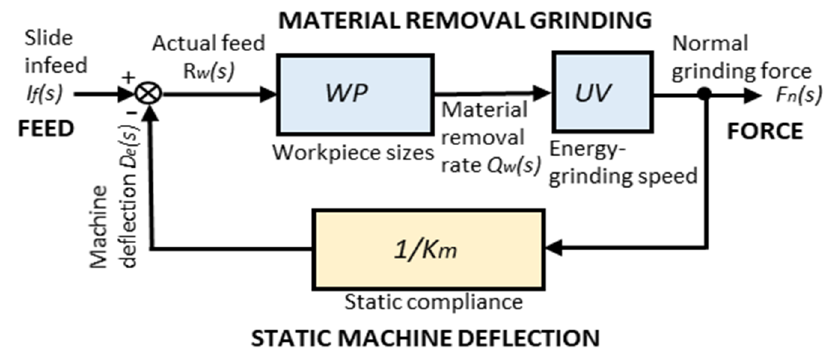
Figure 3. Static grinding model for practical grinding operations.